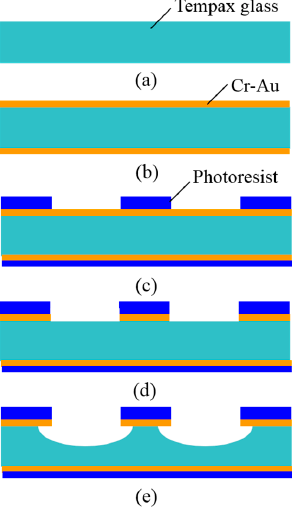
Figure 4. Wet etching process. ( a ) Tempax glass; ( b ) Cr-Au sputter; ( c ) photolithography; ( d ) Cr-Au wet etching; ( e ) glass wet etching.